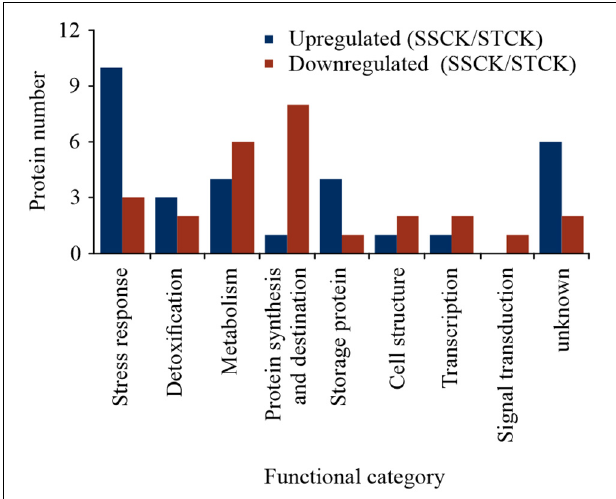
FIGURE 2 | Functional classification of identified differentially abundant proteins between the untreated control group of the storage-tolerant (ST) and of the storage-sensitive (SS) embryos with upregulation (blue) or downregulation (red) according to Bevan et al. (1998) and Zhang et al. (2016). SSCK/STCK represented the comparison of protein abundance between the control group of ST and SS